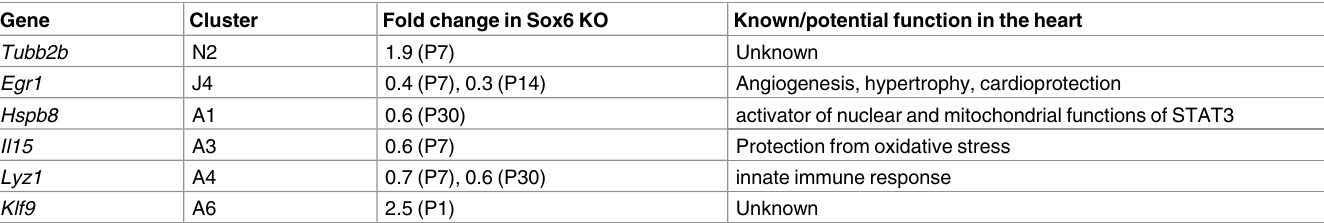
Table 4. DE hub genes in the Sox6 KO